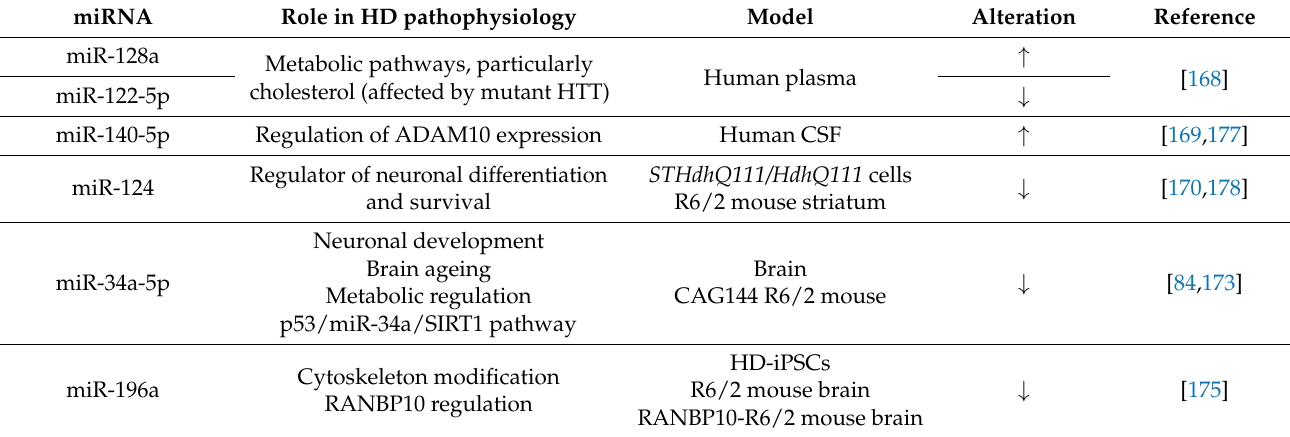
Table 4. miRNAs’ expressions and roles in Huntington disease